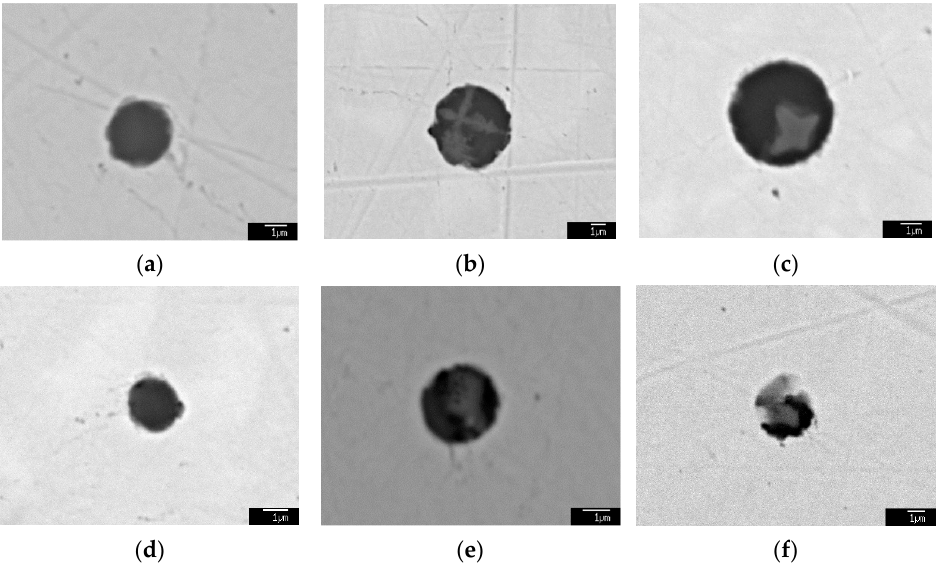
Figure 7. The morphologies of CaO-Al 2 O 3 -SiO 2 -(MgO)-TiO x at different stages: ( a ) Ti addition; (b ) Ca additon; ( c ) LF end; ( d ) VD; ( e ) Tundish; ( f ) product.